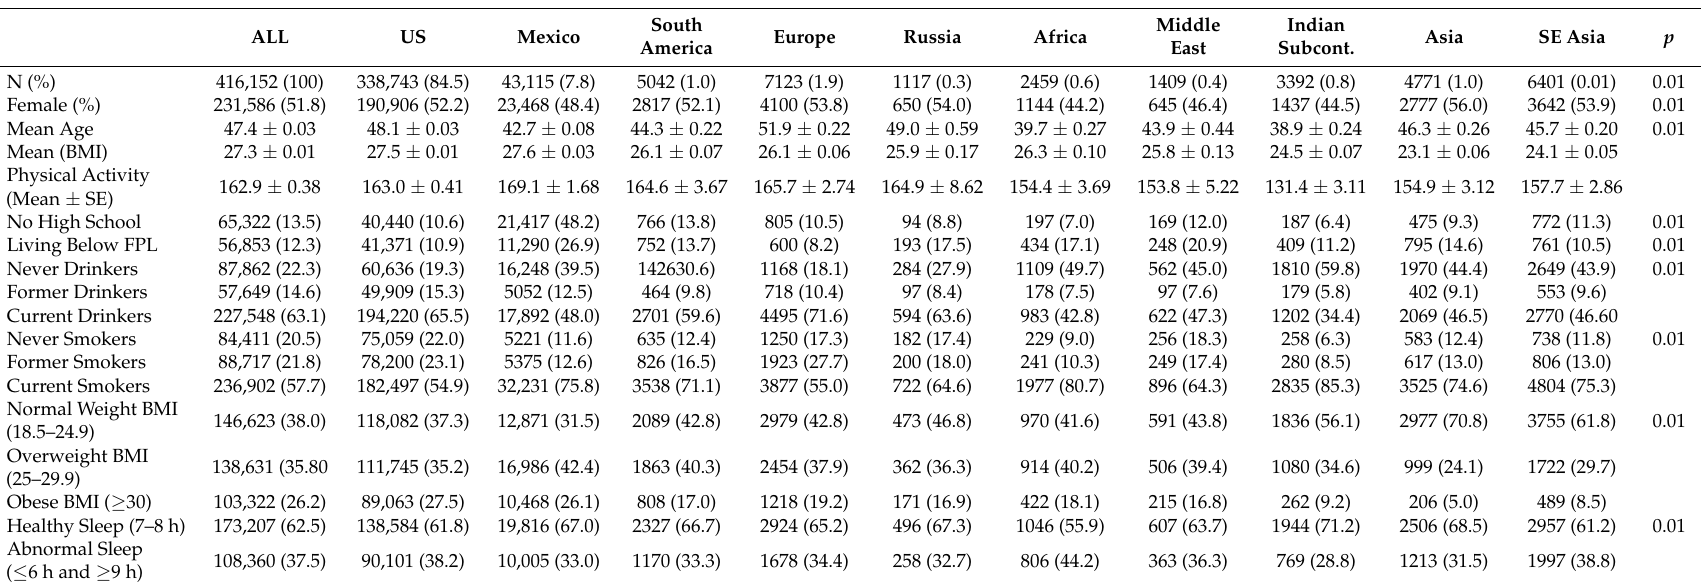
Table 3. Healthy sleep and country of birth by